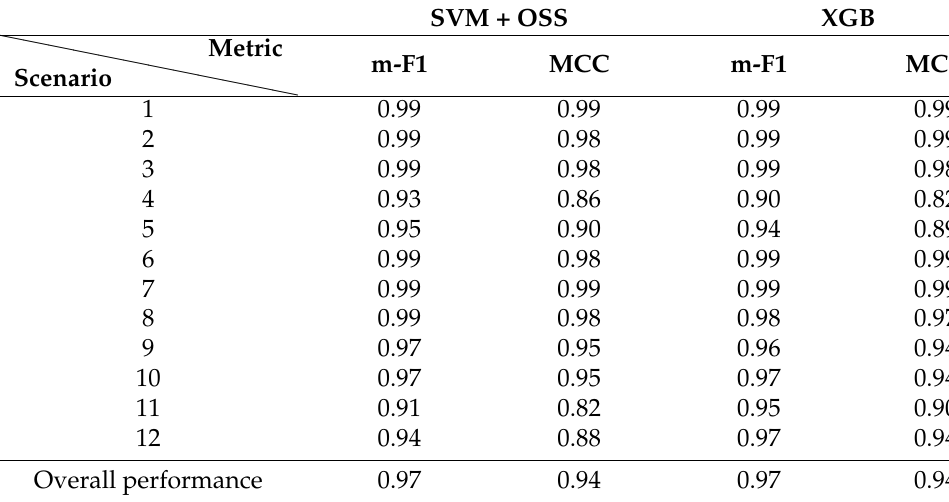
Table 6. Classifiers performance summary.